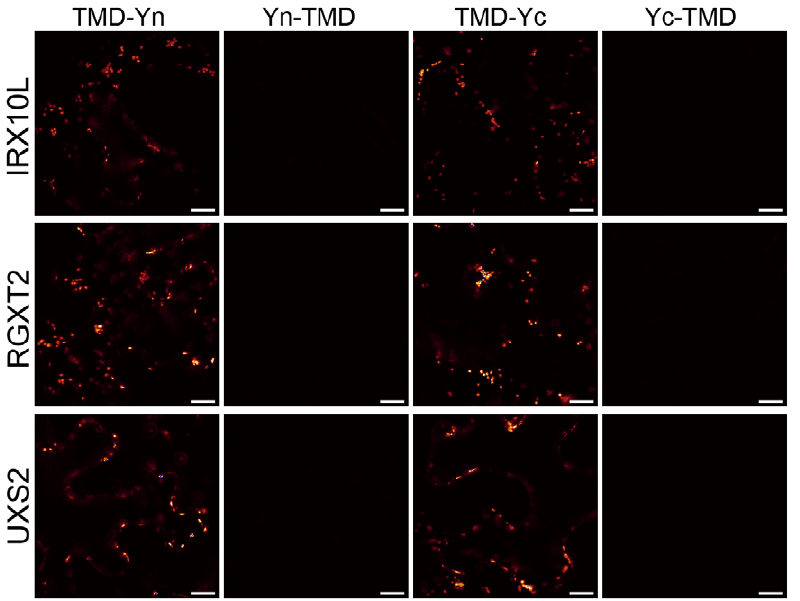
Figure 5. GO-PROMTO analysis of membrane proteins (IRX10L, RGXT2, and UXS2) known to be involved in cell wall polysaccharide biosynthesis in plant. The C-terminal Yc fusion of each of the proteins was co-expressed with TMD-Yn (1 st column) or Yn-TMD (2 nd column) and the C-terminal Yn fusion of each of the protein was co-expressed with TMD-Yc (3rd column) or Yc-TMD (4 th column). The fluorescence complementation with the lumenal reporters and the lack of same with the cytosolic reporters indicate Golgi lumenal orientation of the IRX10L, RGXT2 and UXS2 catalytic domains. Scale bars, 10 m m. At least two individual experiments were performed for each combination with the similar results. Raw images are shown.